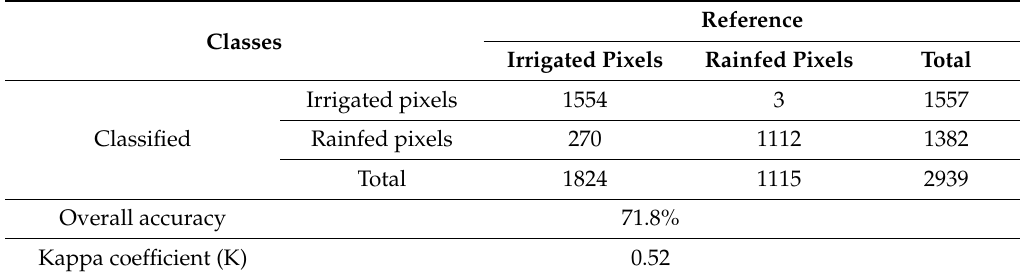
Table 5. Classification accuracy when both soil moisture and NDVI are assessed.